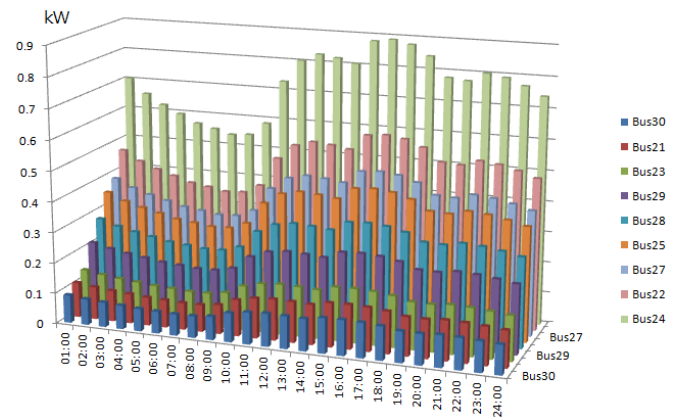
Figure A2. Inelastic loads (MW) in factory power system.